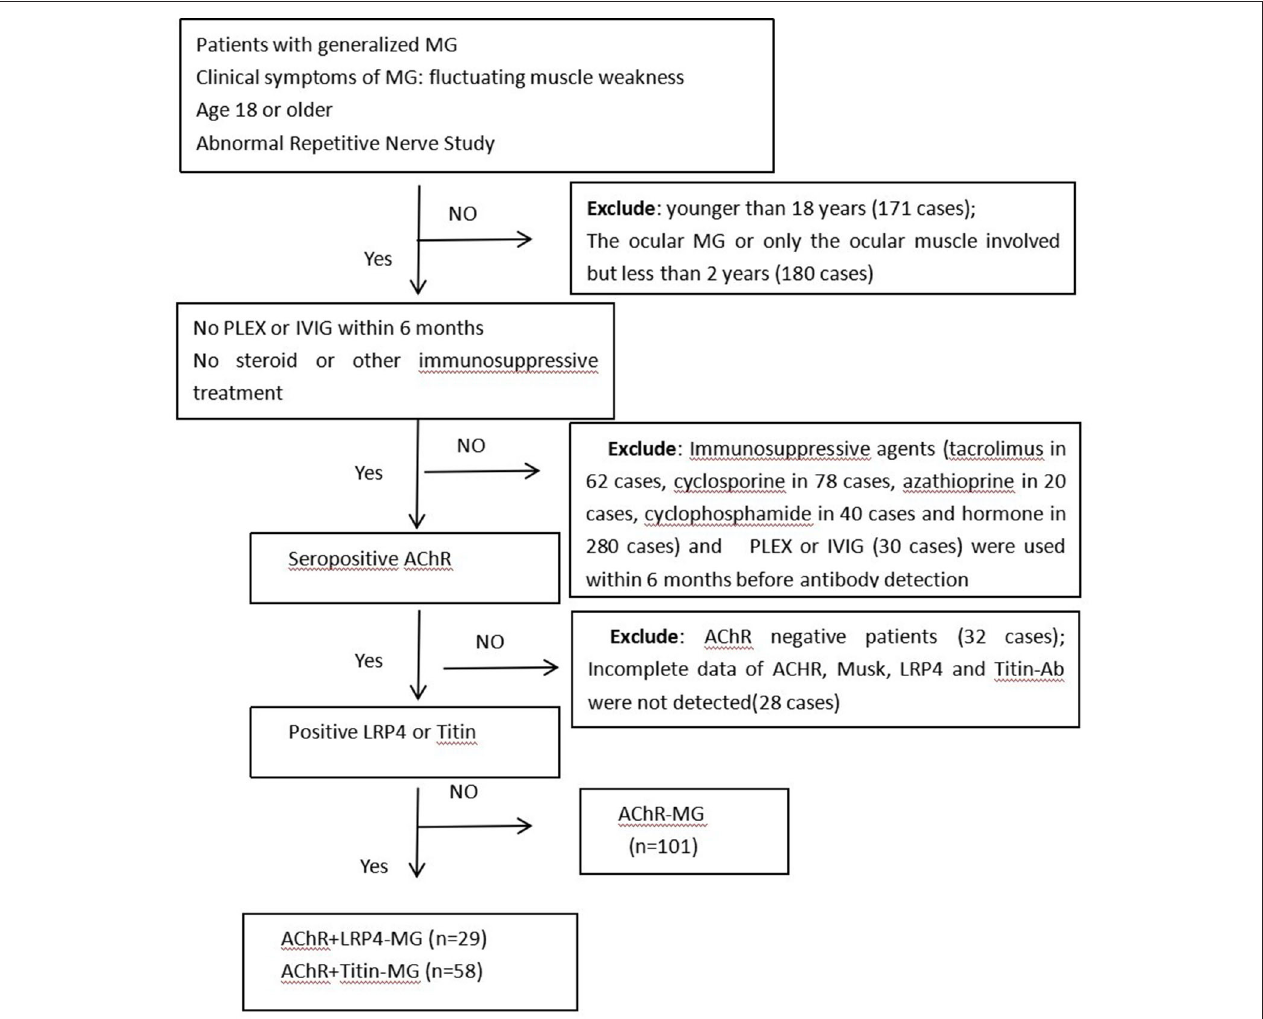
FIGURE 1 | Flowchart of participants included in this study. Abbreviations: MG, Myasthenia gravis; PLEX, plasma exchange; IVIG, intravenous immunoglobulin; AChR, acetylcholine receptor; LRP4, low-density lipoprotein receptor-related protein 4; n, number of